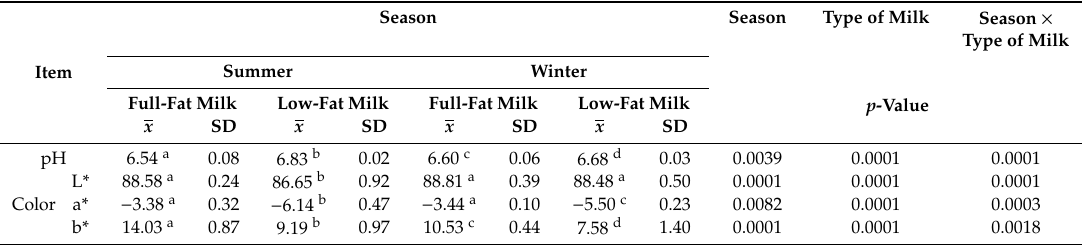
Table 2. Physicochemical parameters of milk depending on the season and the type of milk.